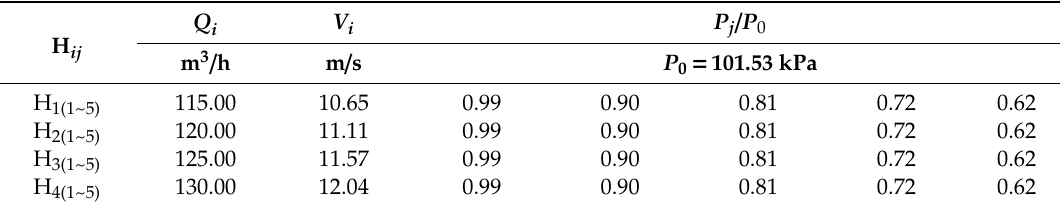
Table 1. Operating conditions parameters of